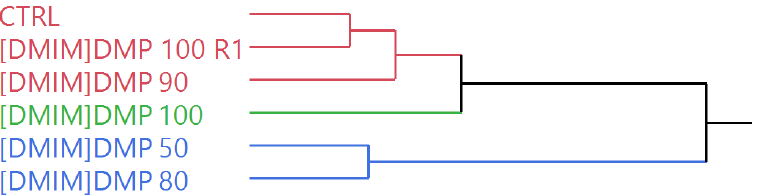
Figure 1. Dendrogram of the hierarchical cluster analysis (HCA) performed on the complete EO compositions of all samples.